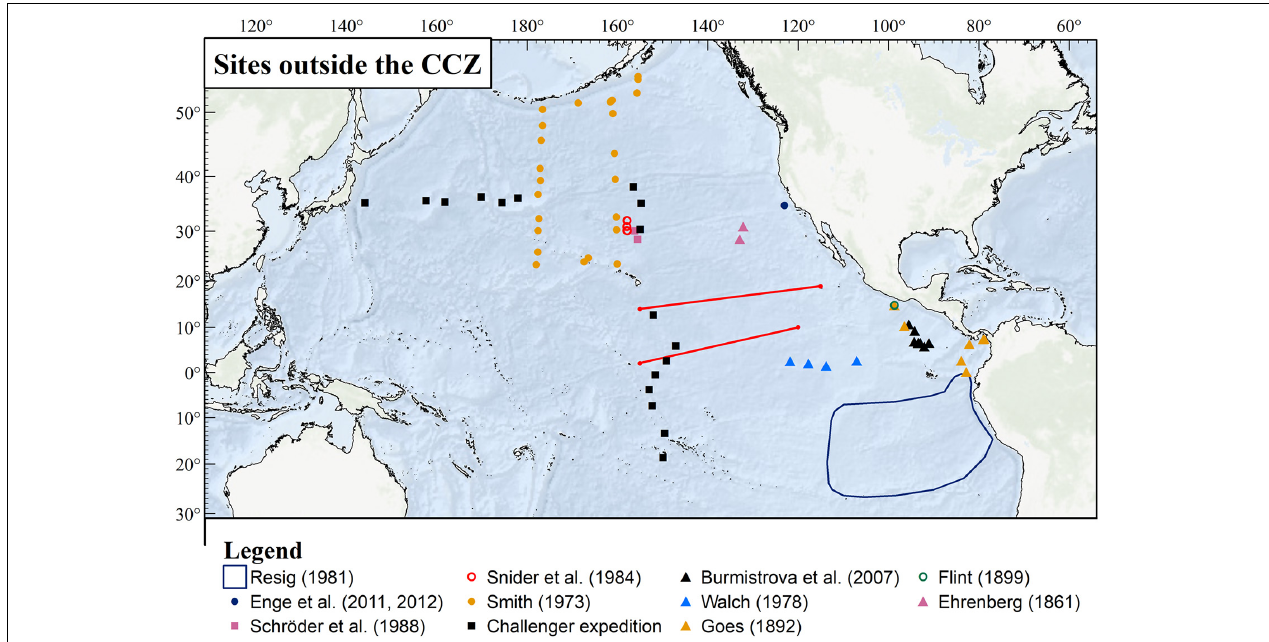
FIGURE 1 | The location of selected studies and sampling sites in the Pacific Ocean. Apart from two Challenger stations at the western end of the CCZ, all are located outside of the CCZ. The Clarion and Clipperton Fractures that delimit the CCZ are marked with red lines; the dark blue line outlines the Resig (1981) study